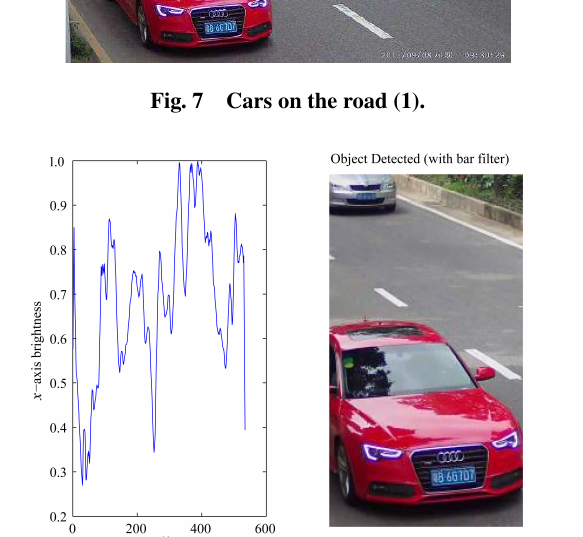
Fig. 8 Horizontal axis’ brightness values and selected car (with bar filter) according to Fig. 7.